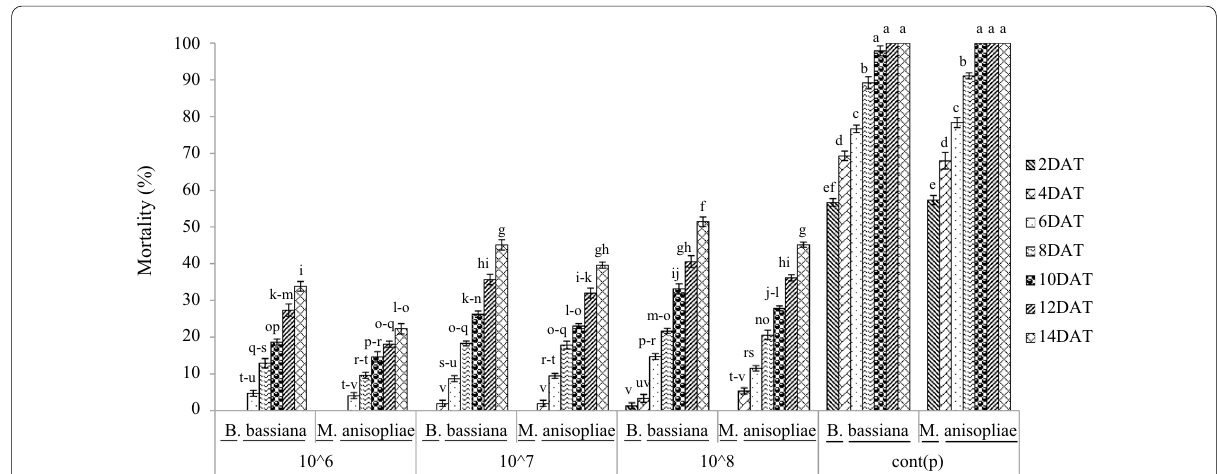
Fig. 2 Oral pathogenicity of Beauveria bassiana and Metarhizium anisopliae against Bactrocera cucurbitae at three concentrations (10 6 , 10 7 and 10 8